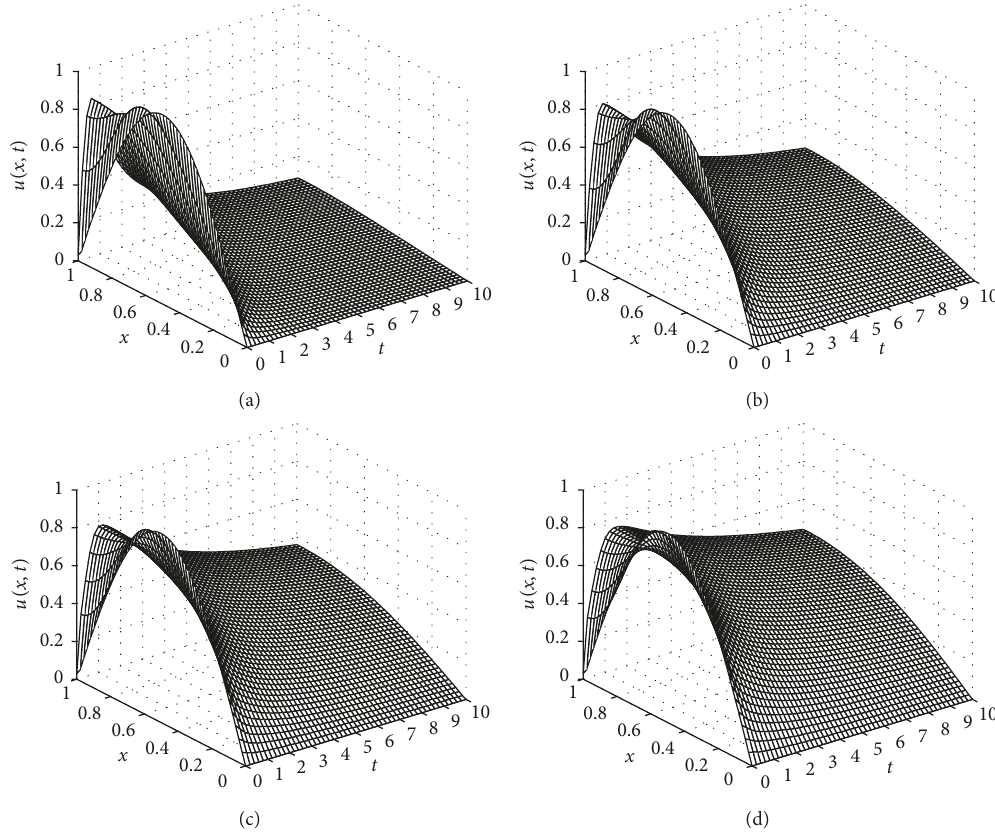
Figure 9: A 3D view of the dynamics of the MGKdVB equation utilizing the third nonlinear adaptive controller μ � 0 . 001, c r � 0 . 2, r � 0 . 2, and u ( x ) � sin ( π x ) . (a) α � 1; (b) α � 2; (c) α � 3; (d) α � 4. 1 2 0